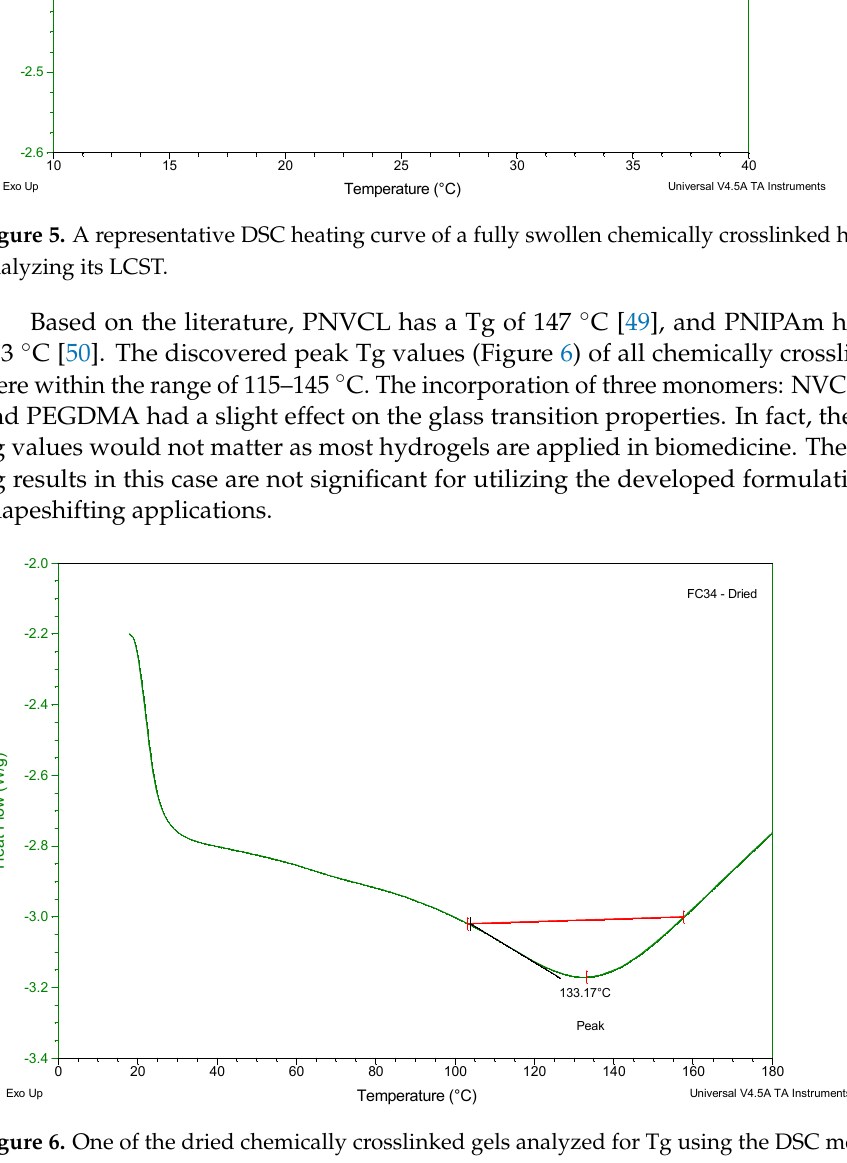
Figure 6. One of the dried chemically crosslinked gels analyzed for Tg using the DSC method.